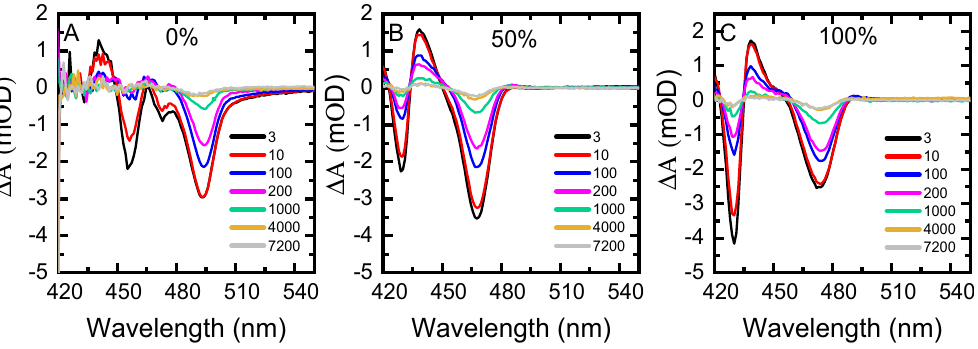
Figure 3. Transient absorption spectra of perovskite samples with no excess ( A ), a 50% excess ( B ), and a 100% excess ( C ) of RbBr at different delay times between pump and probe pulses. The delays are shown in the legend.